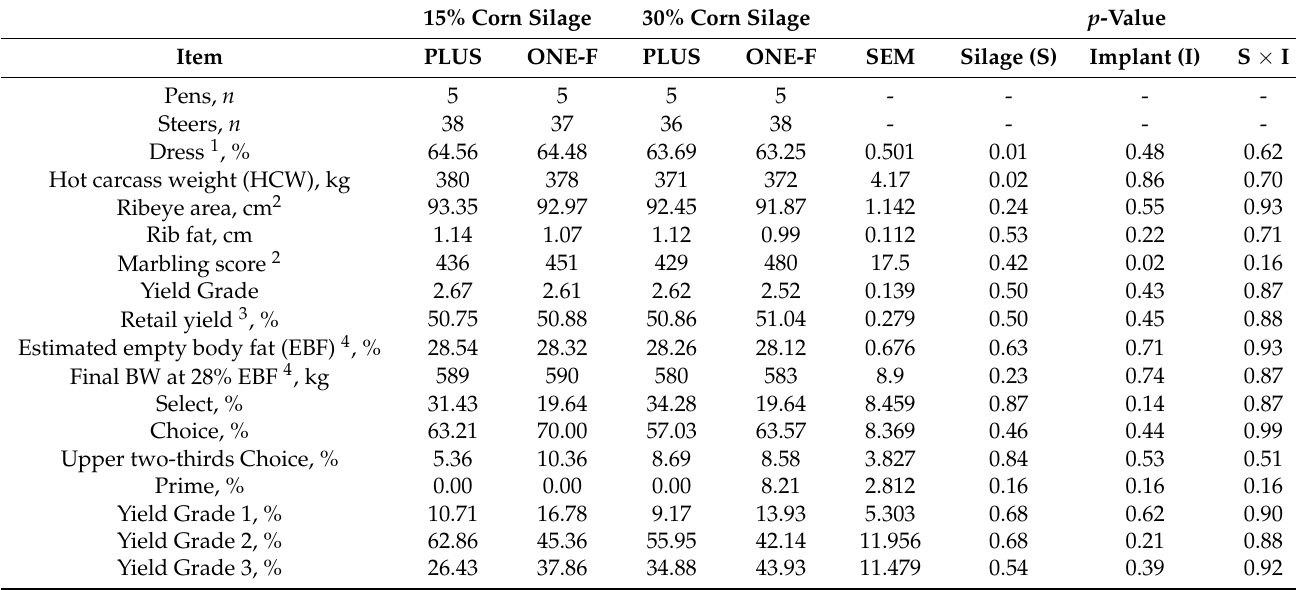
Table 4. Carcass trait responses in finishing diets containing 15% or 30% (DM basis) corn silage and administration of a non-coated (PLUS) or coated (ONE-F) implant containing 200 mg of trenbolone acetate and 28 mg of estradiol